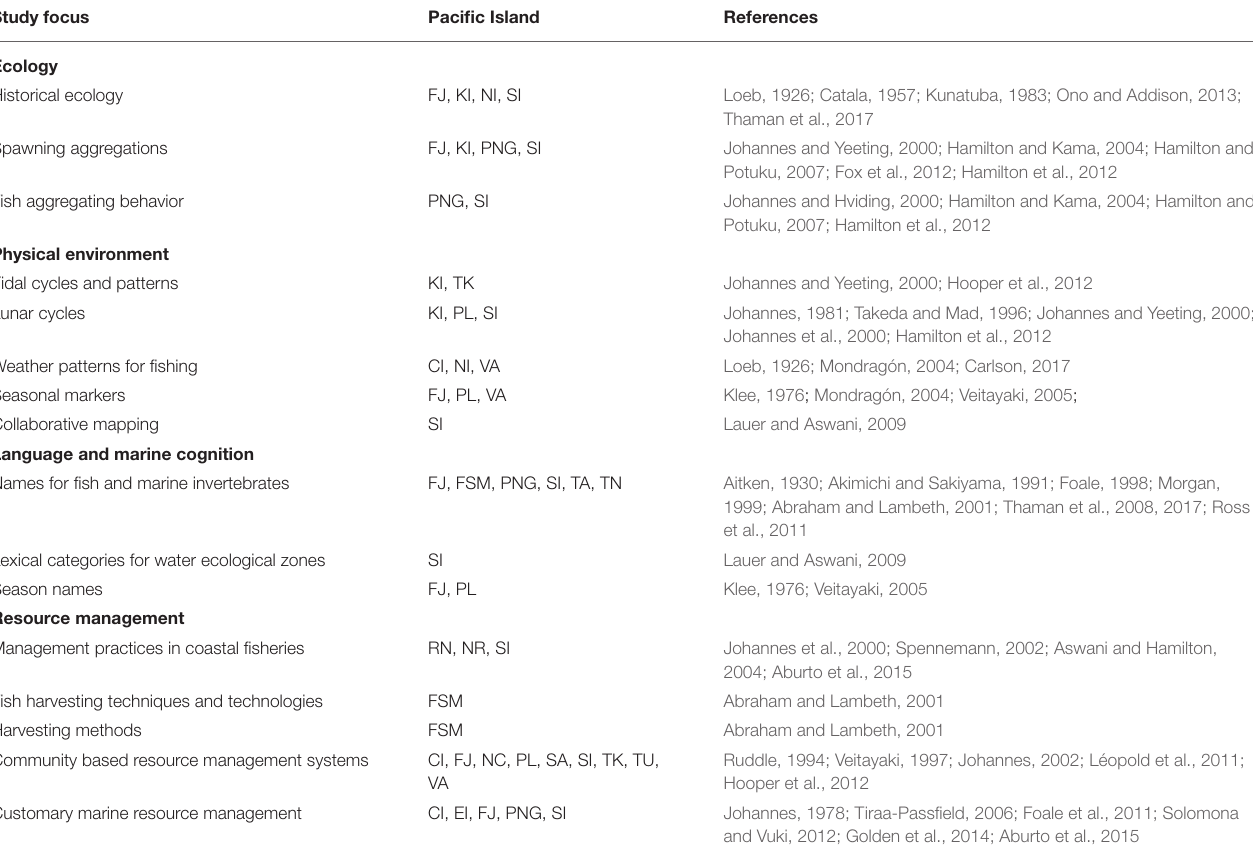
TABLE 2 | Marriage of indigenous fisher knowledge and modern scientific knowledge: examples from literature on Fiji and other Pacific Islands Pacific Islands.